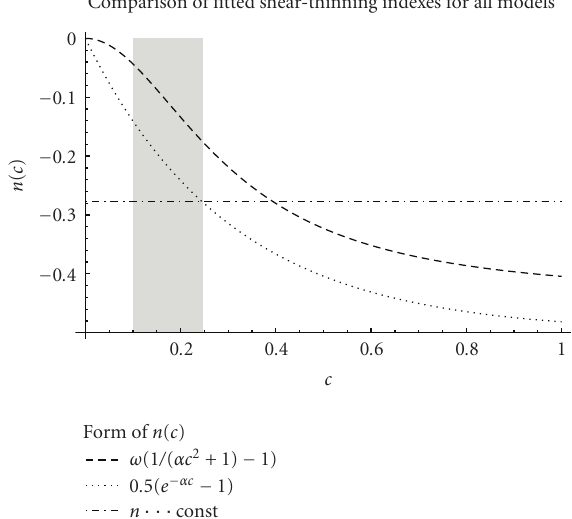
Figure 3: Shear-thinning index for all models. The highlighted area represents the concentration range of the experimental data, thus the mean concentrations in SF under normal physiological conditions.